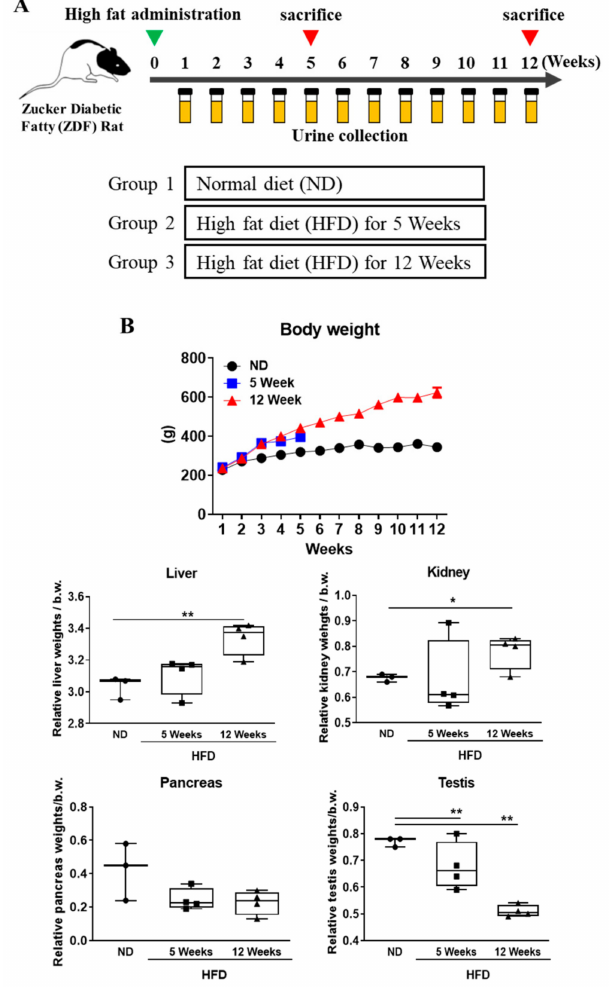
Figure 1. Experimental design and body weight and organ weight changes. ( A ) Zucker diabetic fatty rats were divided into three groups (normal diet group, high fat diet groups (5 and 12 weeks)). Urine samples were collected from all subjects weekly. ( B ) Body, liver, pancreas, and testis weight were measured in each group. All results showed changes in relative organ weight ratio (%) at indicate time point. Data are expressed as the mean ± SD of each group. * p < 0.05; ** p < 0.01; ND, normal diet; HFD, high-fat